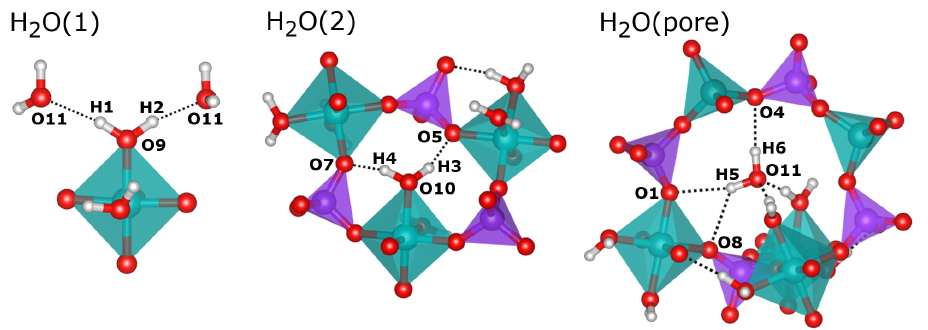
Figure 3. Visualisation of the environment of water molecules in the DFT-optimised structure of AlPO 4 -H3.